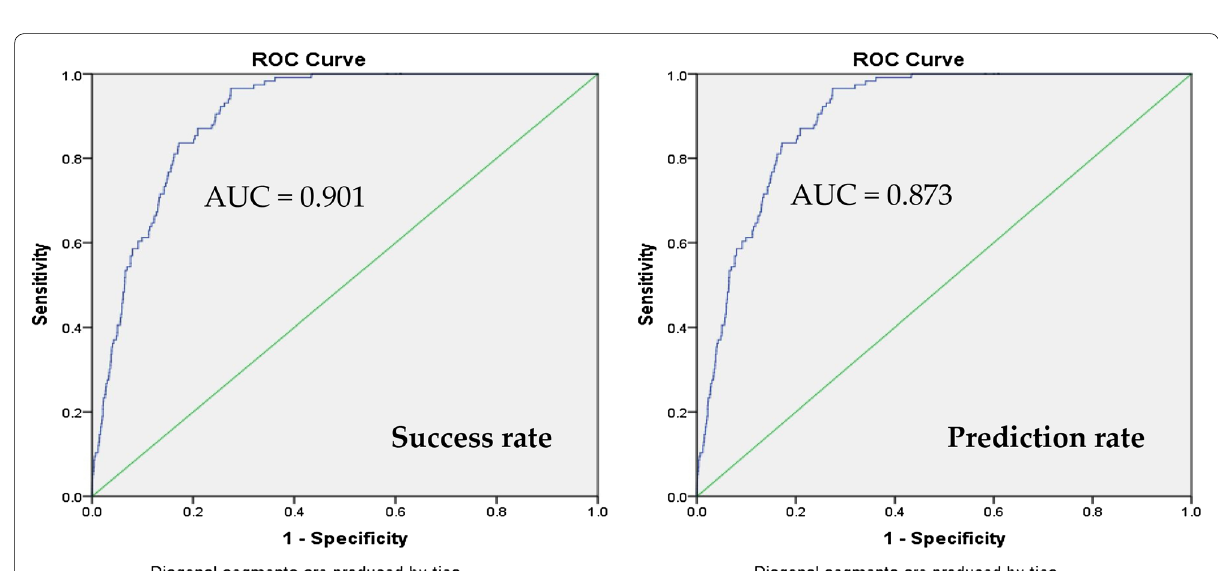
Fig. 11 Success rate and prediction rate diagram showing percentage of study area classified as susceptible ( x -axis) in cumulative percent of landslide events ( y